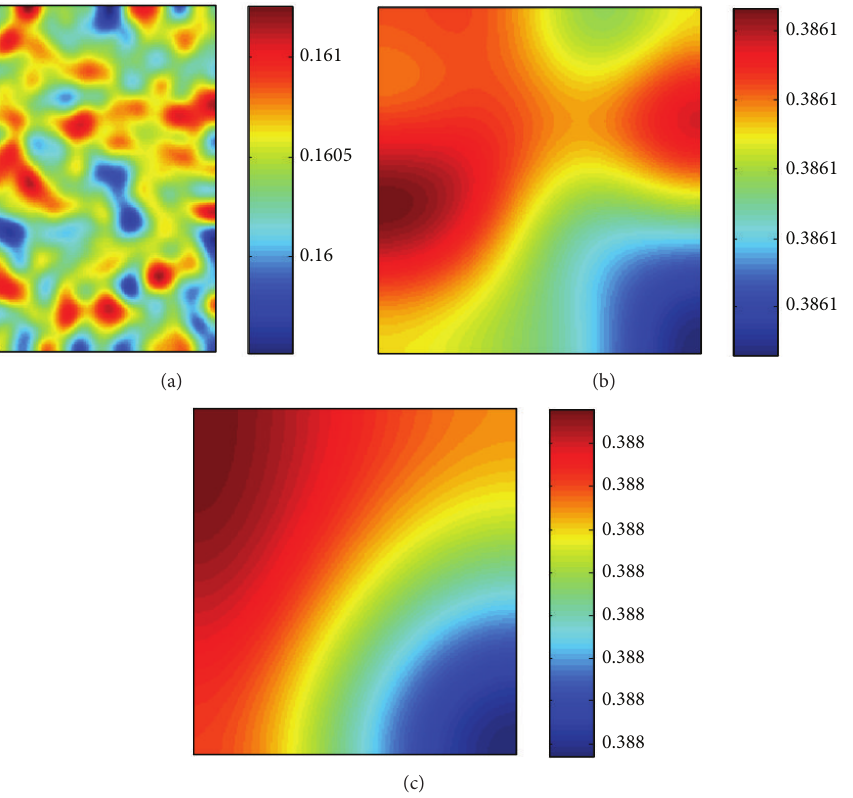
Figure 8: Snapshots of contour pictures of the time evolution of predator in system (3) when 𝑑 2 = 2 and 𝛿 𝑇 < 𝛿 = 0.34 < 𝛿 𝐻 : (a) 1000 iterations, (b) 50000 iterations, and (c) 200000